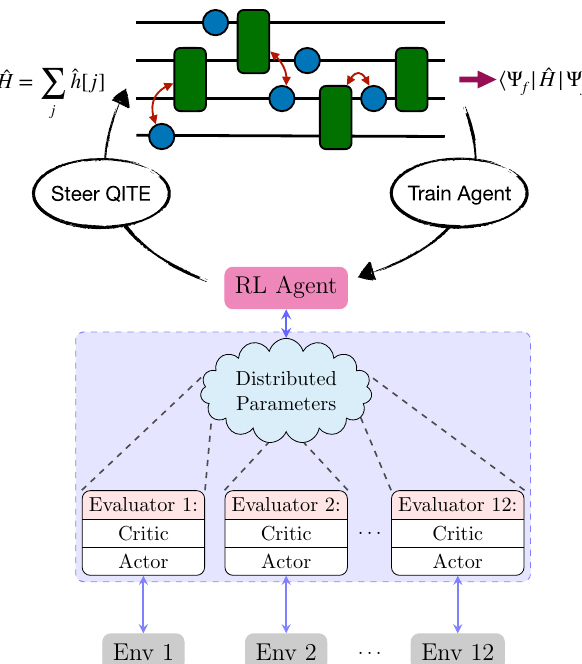
Fig. 5 Schematic of steering the quantum imaginary time evolution with reinforcement learning. The colored symbols represent single-qubit (blue dots) and two-qubit (green rectangles) non-unitary operations f e (cid:3) Δ τ ^ h ½ j (cid:2) g . The reinforcement learning (RL) agent, realized by neural networks, interacts with different environments (Env 1, Env 2, … , Env 12) and optimizes the operation order to minimize the output state